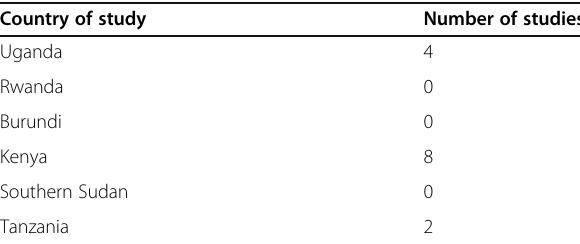
Table 2 Distribution of eligible research articles on